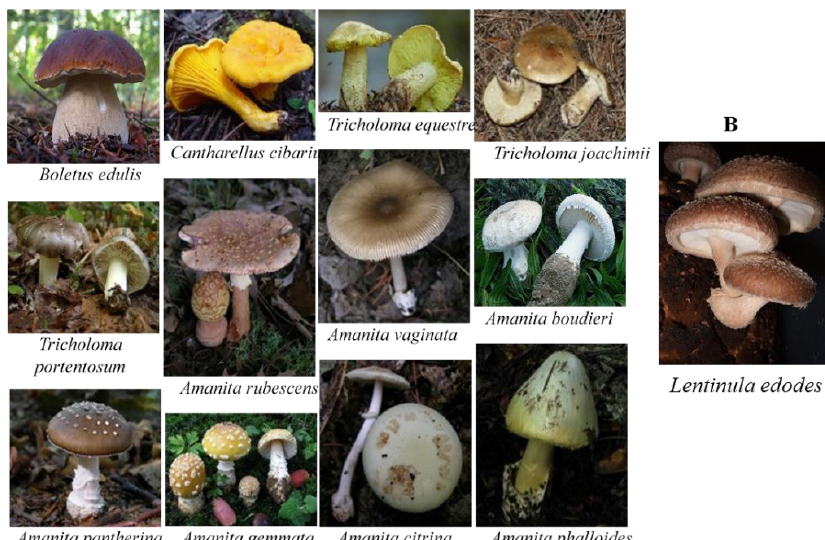
Figure 2. Pictures of ( A ) some wild mushrooms collected in the Inner Central Region of Portugal and ( B ) Lentinula edodes mushroom used in this work.